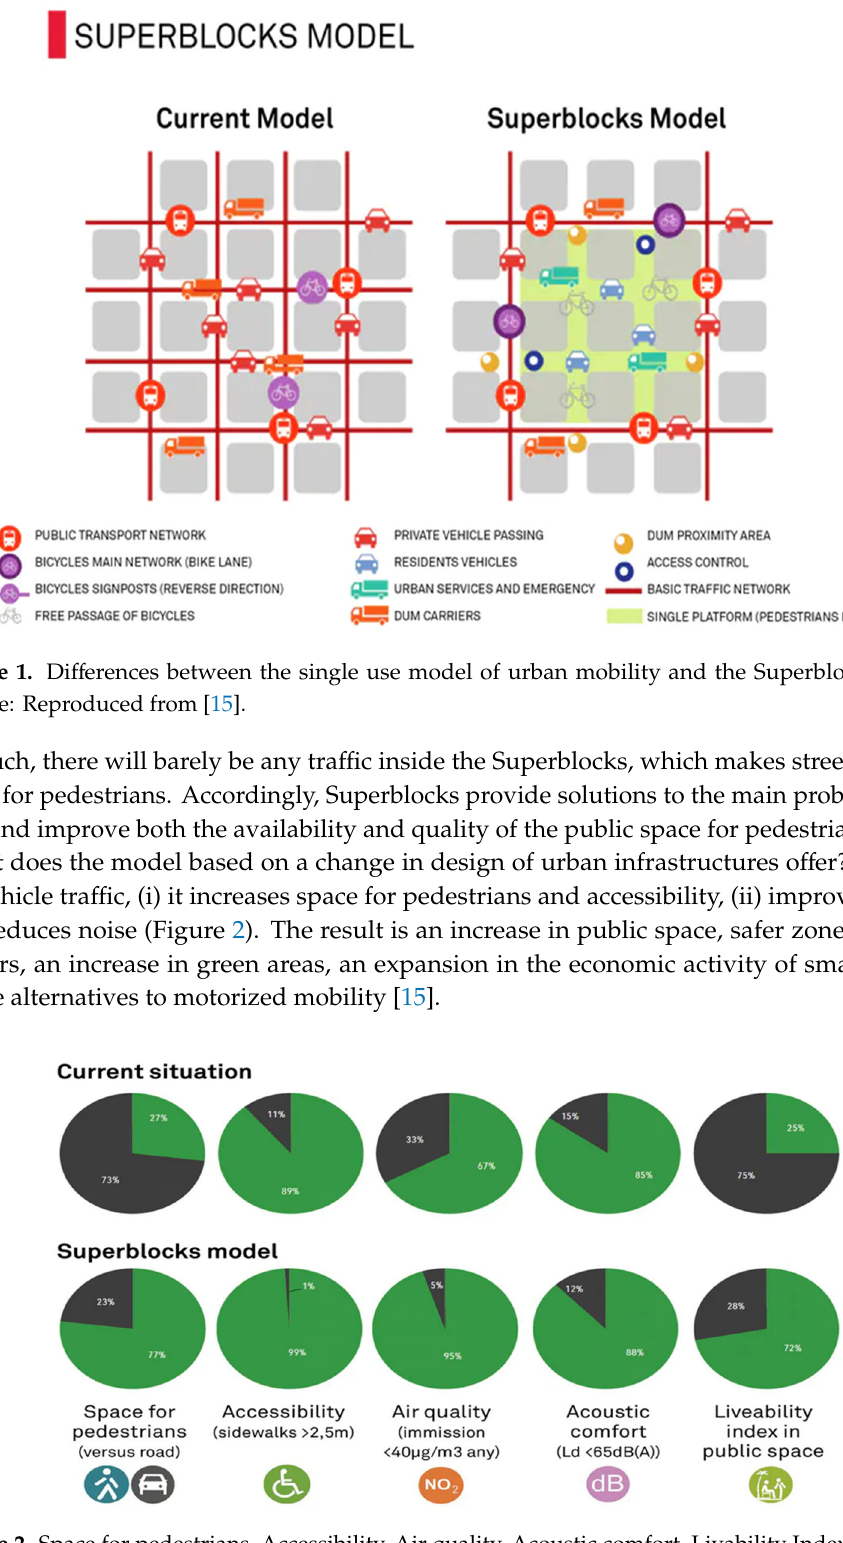
Figure 2. Space for pedestrians, Accessibility, Air quality, Acoustic comfort, Livability Index in public space. Current situation. Superblocks model. Barcelona. Source: Reproduced from [25].